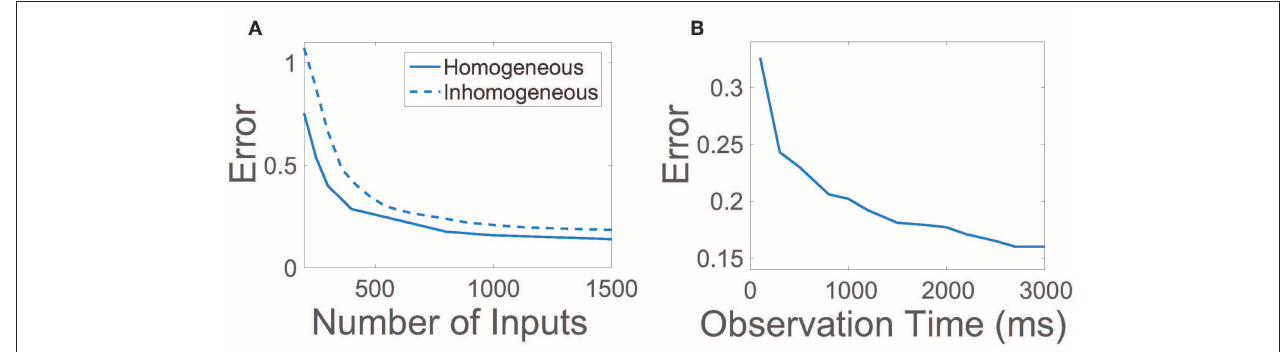
FIGURE 3 | Efficiency and robustness of CS network reconstruction. (A) Relative reconstruction error as a function of the number of random input vectors r utilized. Solid line depicts error using homogeneous thresholds θ E inhomogeneities δ i k (0, d ) are uniformly distributed random variables and d ∈ function of observation time. In each case, 900 random input vectors are